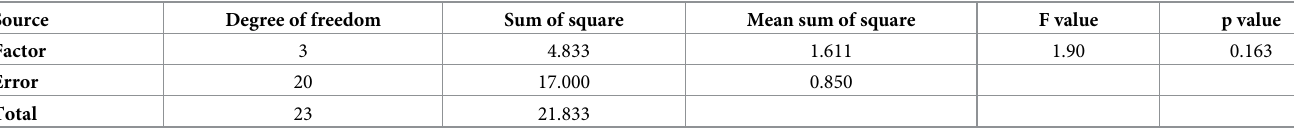
Table 4. ANOVA results for different regions.